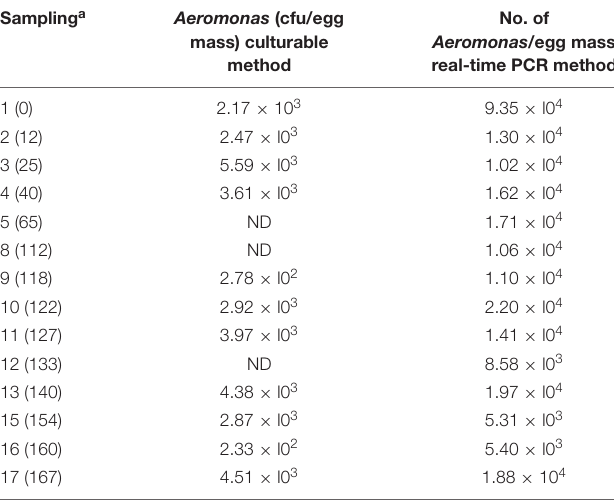
TABLE 1 | Abundance of Aeromonas in chironomid egg masses collected from the Tivon